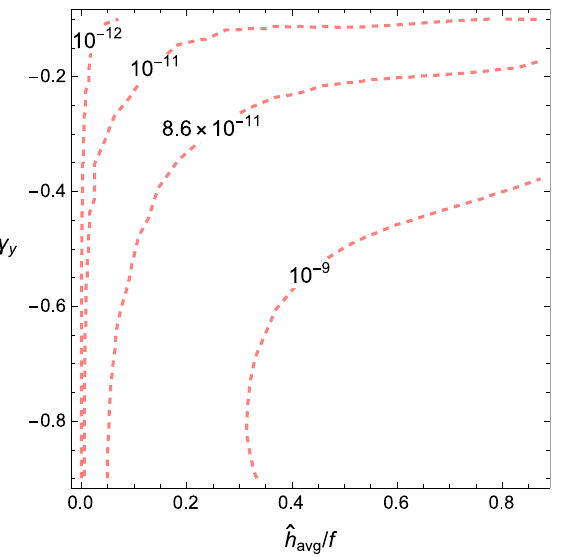
Figure 12 . The produced baryon asymmetry assuming the U(1) (cid:13)avour symmetries. As the reheating temperature is generally too high for a glueball dilaton, we focus here on the meson case, for which we have set m (cid:31) = 500 GeV and N = 5. The measured baryon asymmetry (cid:17) B = n B =s ’ 8 : 6 (cid:2) 10 (cid:0) 11 [58] is shown as a contour